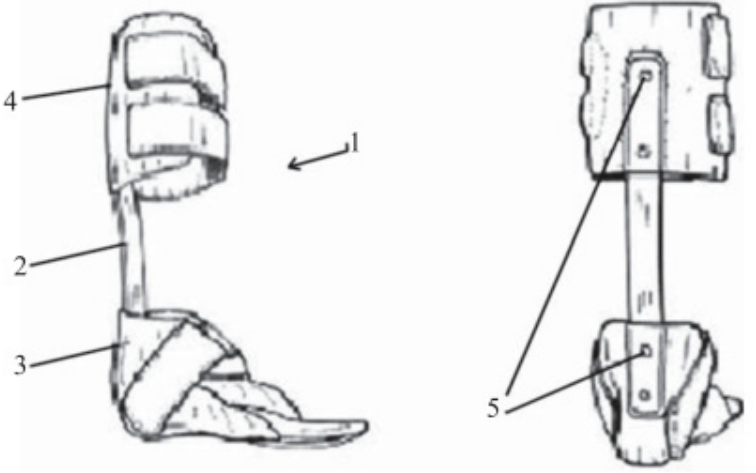
Figure 6. AFO with a strut module system: (1) Velcro strap; (2) strut module; (3) foot plate; (4) shank holder [19].